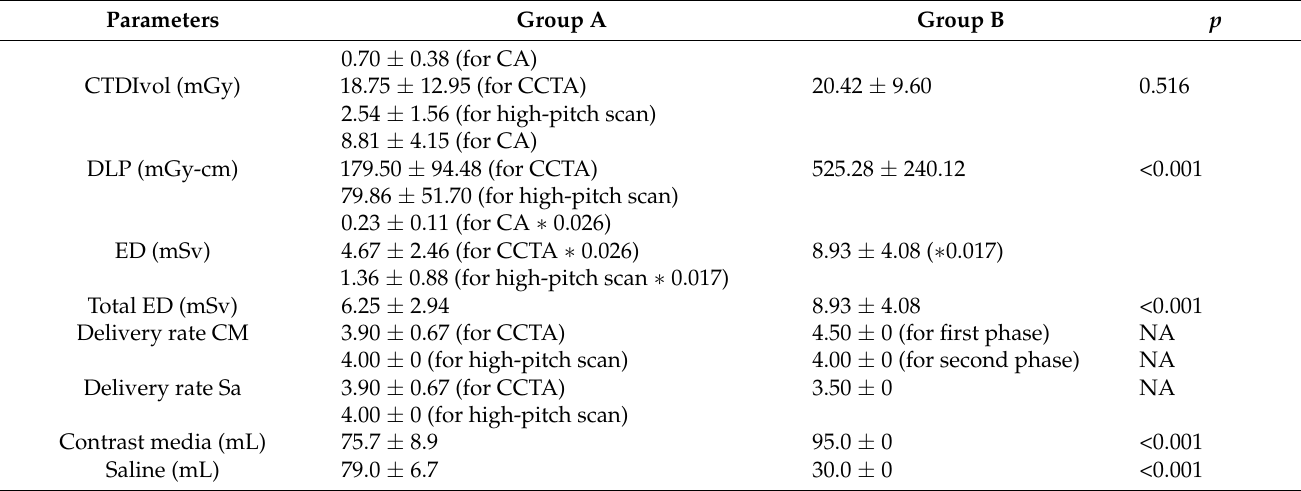
Table 2. Comparison of radiation dose parameters between two different TRO-CTA protocols.